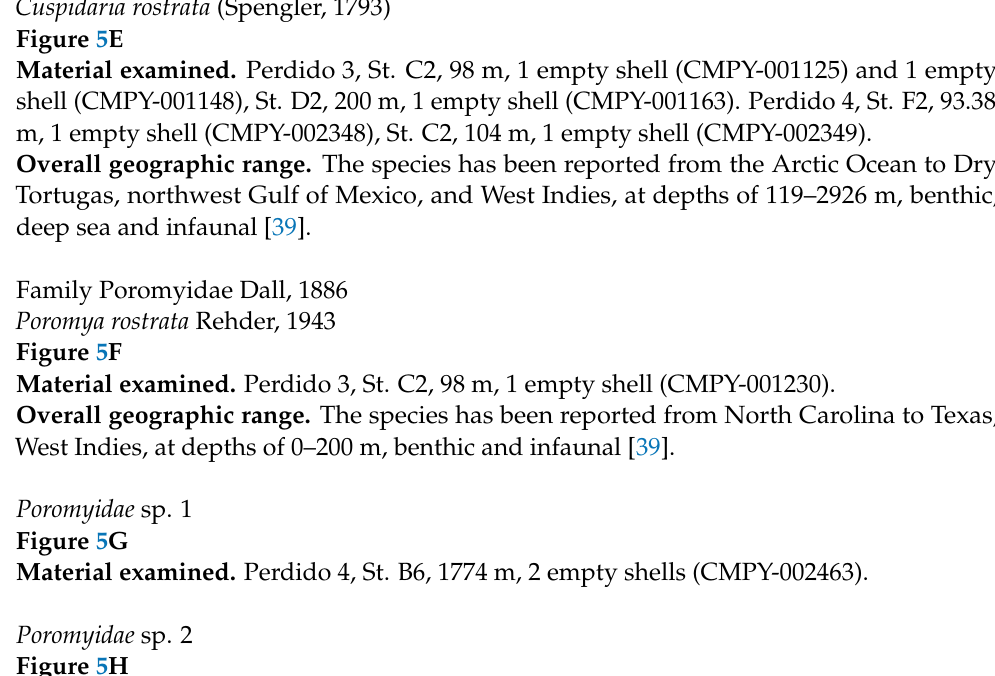
Corbula sp. Figure 5B Material examined. Perdido 4, St. C1, 48.23 m, 1 empty shell (CMPY-002366). Juliacorbula aequivalvis (Philippi, 1836) Figure 5C Material examined. Perdido 4, St. D1, 43.48 m, 8 empty shells (CMPY-002445). Overall geographic range. The species has been reported from Florida Straits to Florida Keys, North Gulf of Mexico, Cuba, Antilles, and Central America, at depths of 0–101 m, benthic and infaunal [39]. Cardiomya sp. Figure 5D Material examined. Perdido 3, St. D2, 200 m, 1 empty shell (CMPY-001149). Family Cuspidariidae Dall, 1886 Cuspidaria rostrata (Spengler, 1793) Figure 5E Material examined. Perdido 3, St. C2, 98 m, 1 empty shell (CMPY-001125) and 1 empty shell (CMPY-001148), St. D2, 200 m, 1 empty shell (CMPY-001163). Perdido 4, St. F2, 93.38 m, 1 empty shell (CMPY-002348), St. C2, 104 m, 1 empty shell (CMPY-002349). Overall geographic range. The species has been reported from the Arctic Ocean to Dry Tortugas, northwest Gulf of Mexico, and West Indies, at depths of 119–2926 m, benthic; deep sea and infaunal [39]. Family Poromyidae Dall, 1886 Poromya rostrata Rehder, 1943 Figure 5F Material examined. Perdido 3, St. C2, 98 m, 1 empty shell (CMPY-001230). Overall geographic range. The species has been reported from North Carolina to Texas, West Indies, at depths of 0–200 m, benthic and infaunal [39]. Poromyidae sp. 1 Figure 5G Material examined. Perdido 4, St. B6, 1774 m, 2 empty shells (CMPY-002463). Poromyidae sp. 2 Figure 5H Material examined. Perdido 4, St. C2, 104 m, 1 empty shell